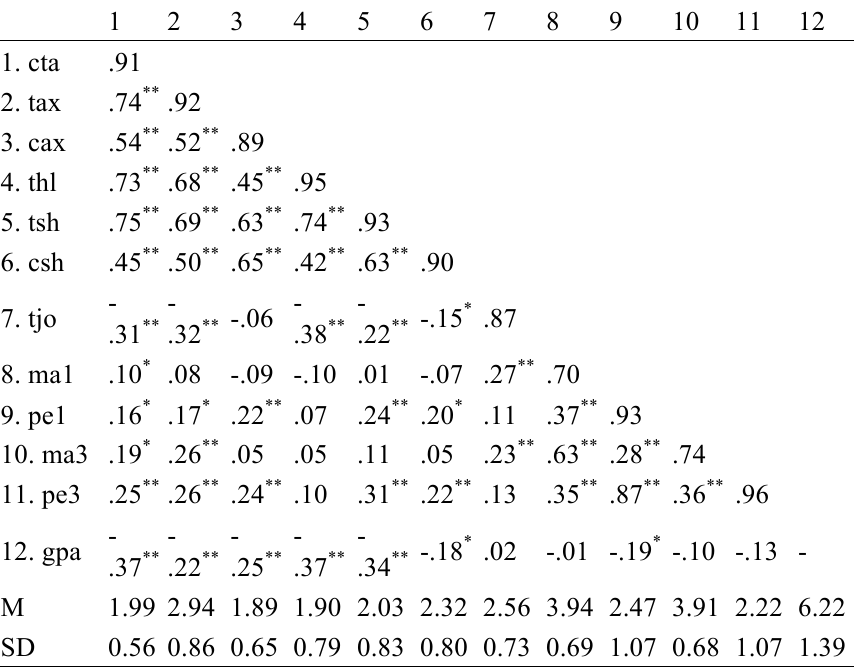
Descriptive statistics and bivariate